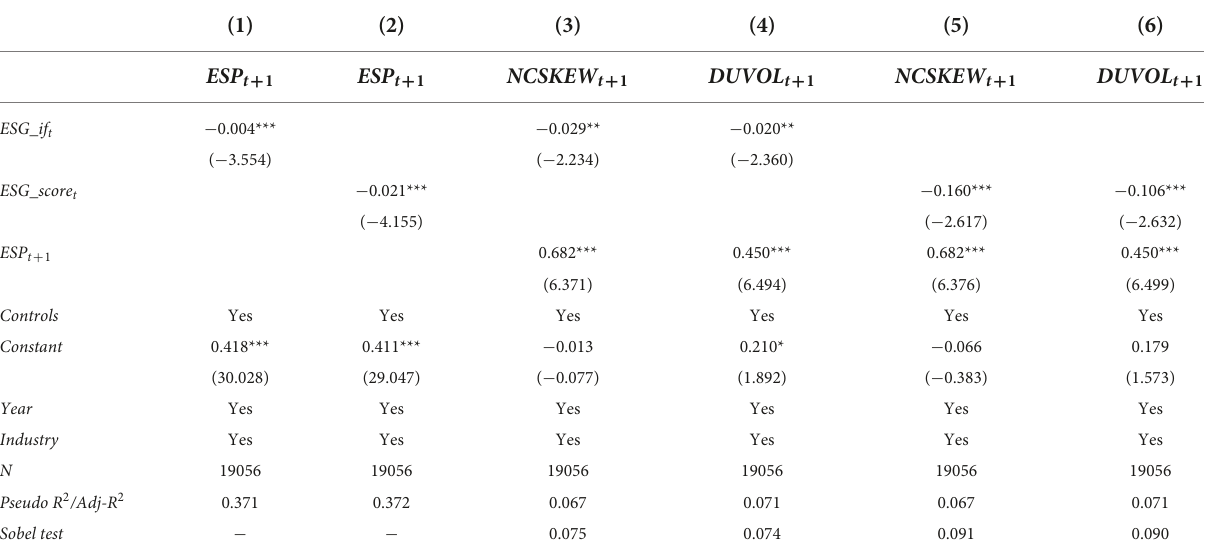
TABLE 9 Mechanism analysis: Information